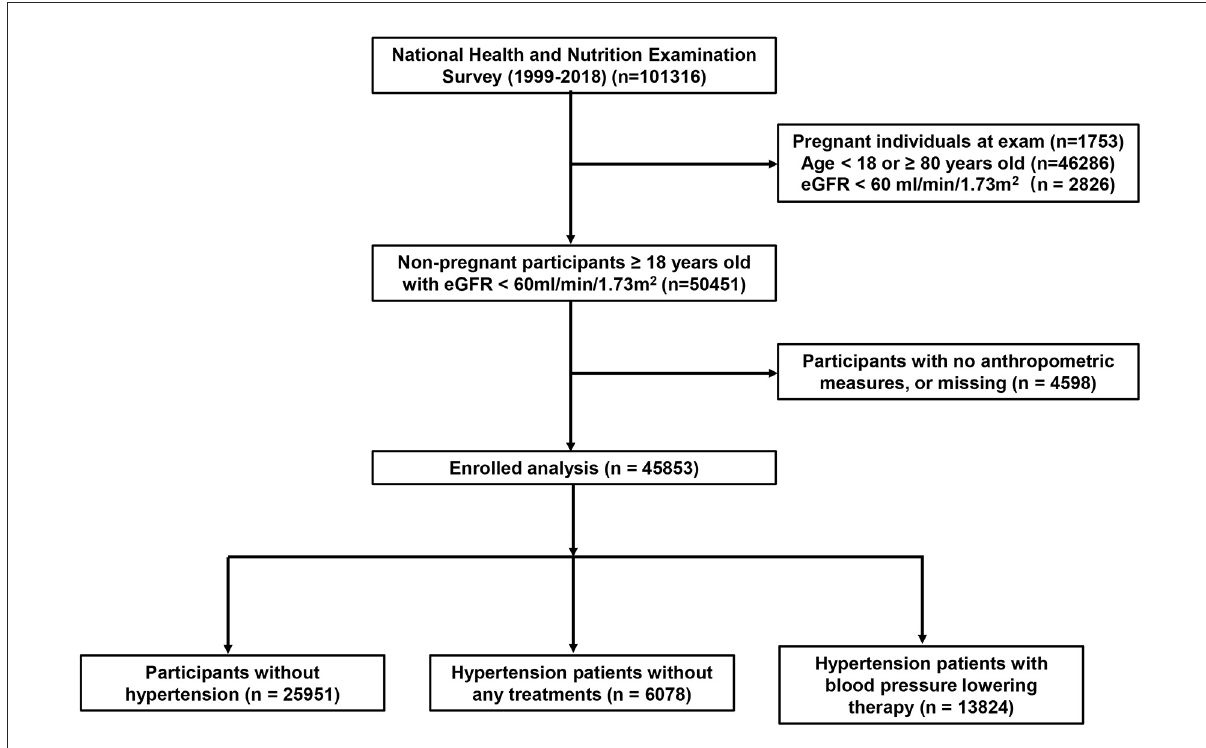
FIGURE1 Flowchart of the study population. eGFR, estimated glomerular filtration